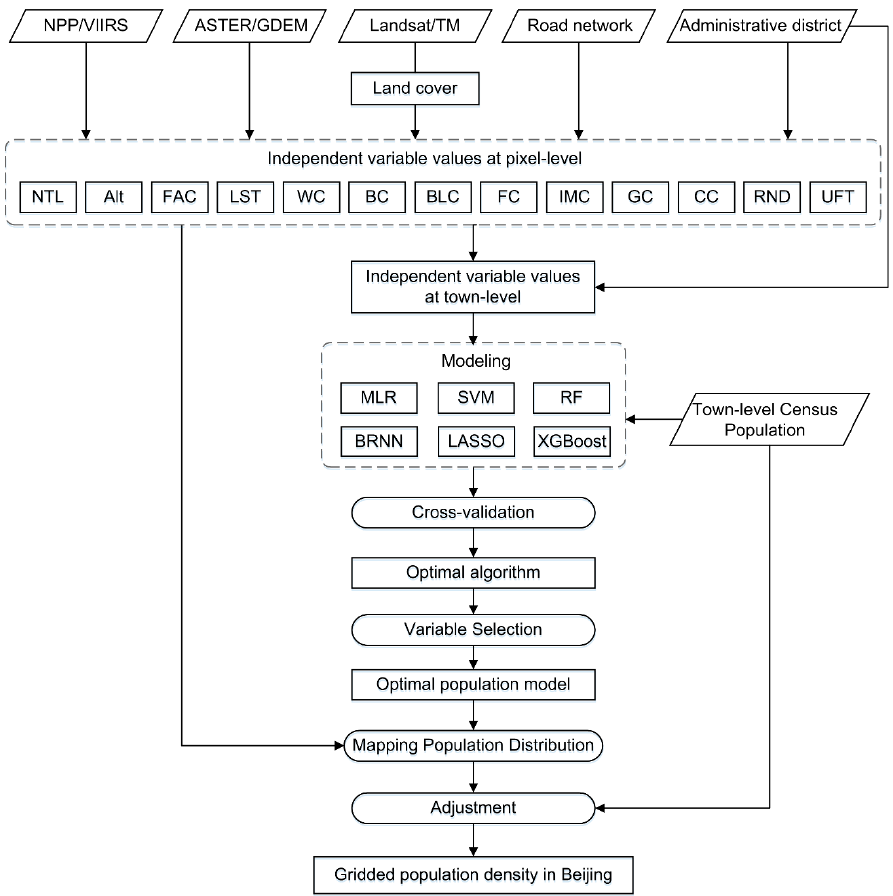
Figure 3. Flowchart of population spatialization in Beijing.